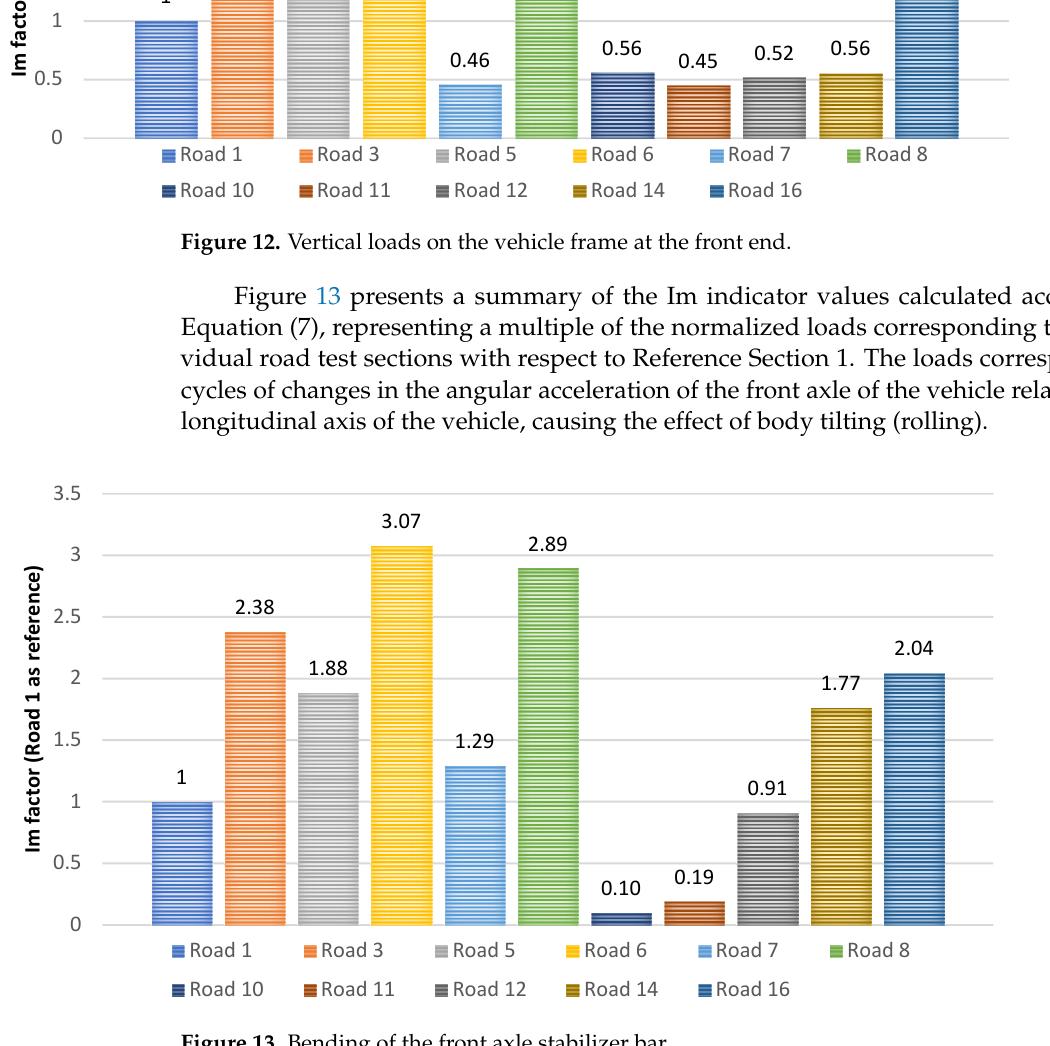
Figure 13. Bending of the front axle stabilizer bar.